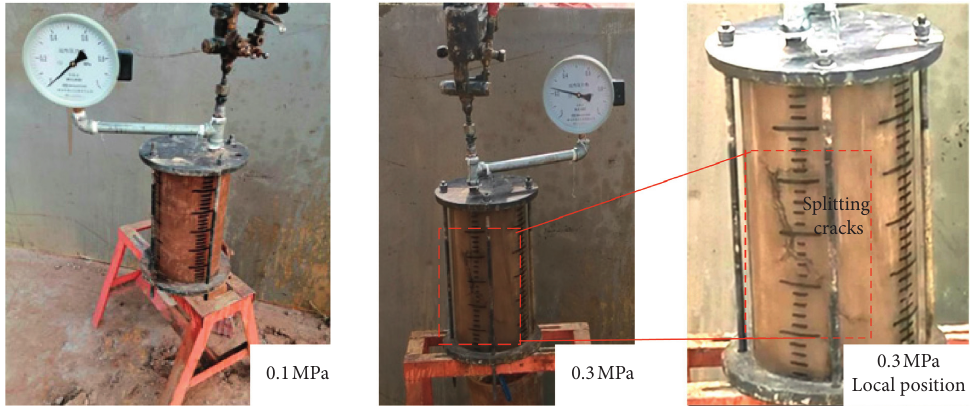
Figure 8: Grouting process under grouting pressures of 0.1MPa and